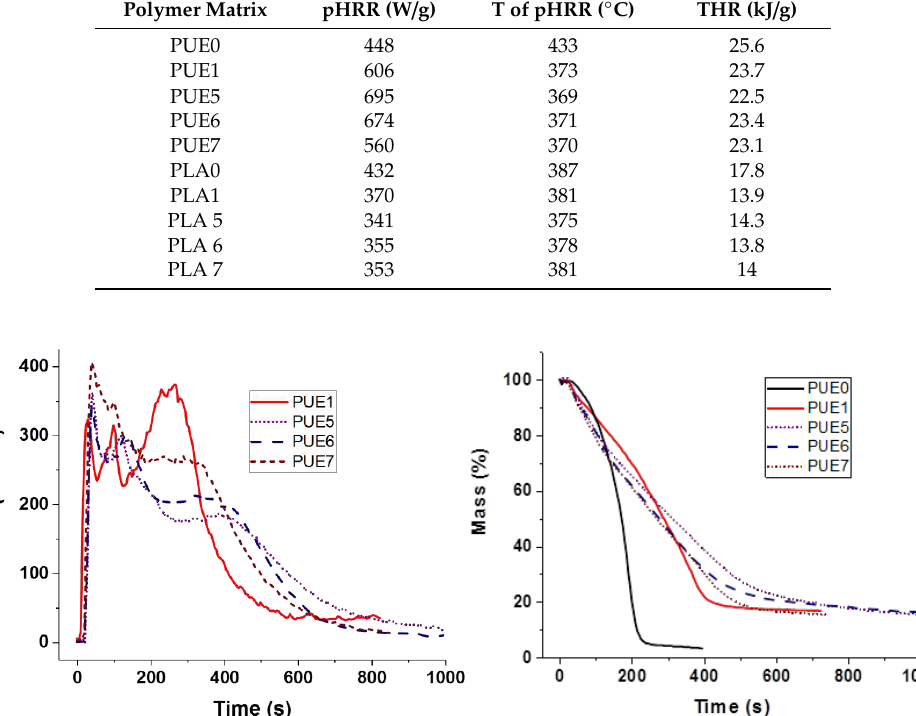
Figure 15. Heat release rate and mass for PUE/APP/lignin composites from cone calorimeter.